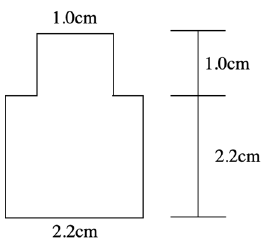
Figure A1. Shape and dimensions of the finger model. In this model, the thickness used was 1 cm.